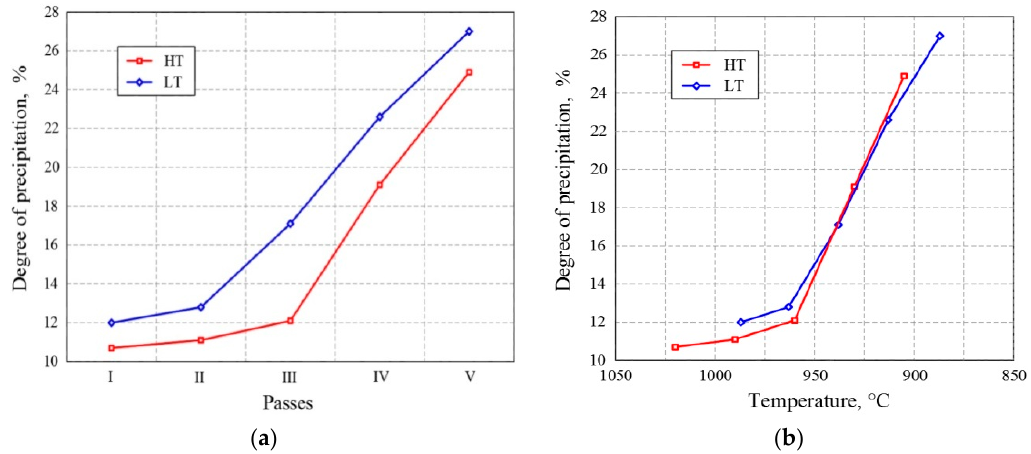
Figure 4. Change in precipitation degree ( a ) through passes and ( b ) with the temperature of thermomechanical processing.